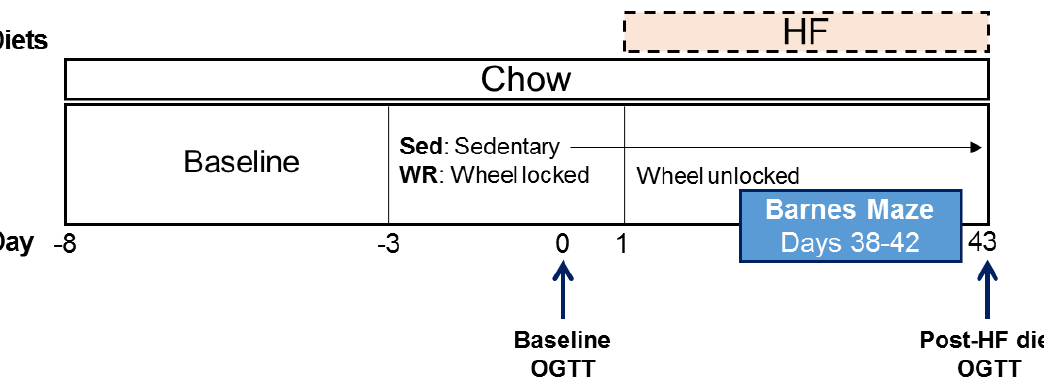
Figure 1. Experimental timeline. Sed: sedentary, WR: wheel running; HF: high fat; OGTT: oral glucose tolerance test.